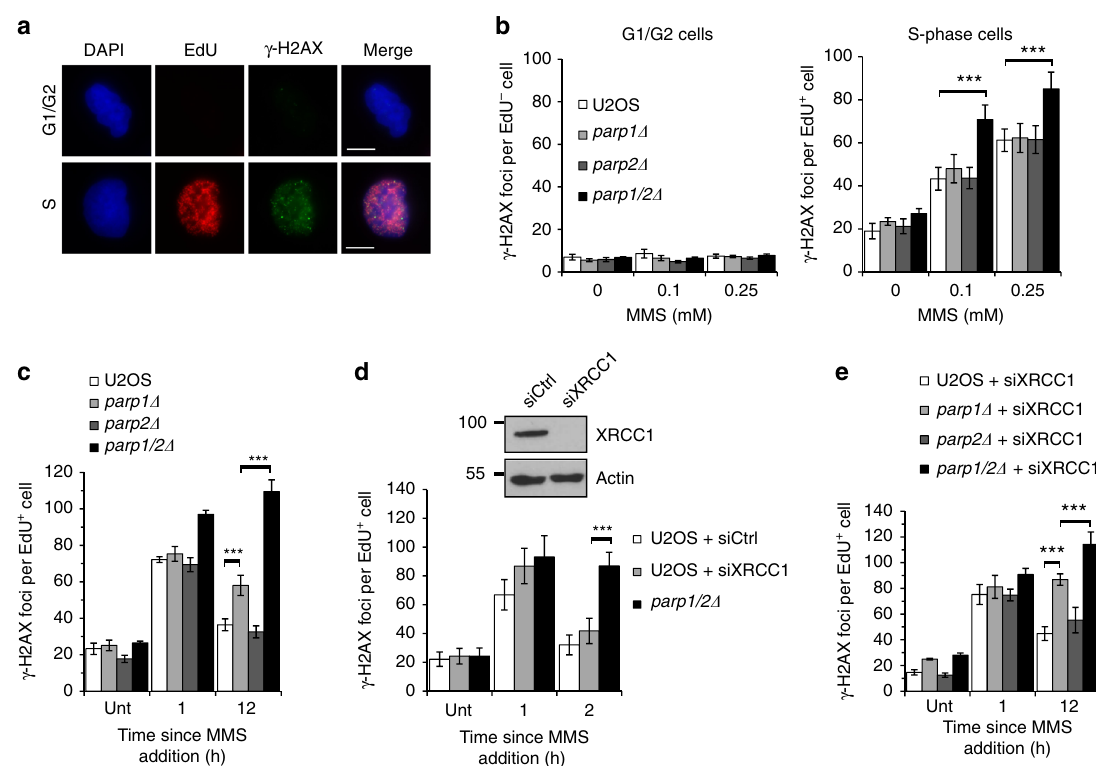
Fig. 3 PARP1 and PARP2 function in the resolution of replication-associated damage independently of BER. a U2OS cells were treated with 1 μ M EdU and 0.25 mM MMS for 1 h, before pre-extraction and fi xation. EdU and γ -H2AX were detected by immuno fl uorescence. Representative images of EdU-positive and EdU-negative nuclei are shown. Scale bars represent 10 μ m. b The indicated cell lines were treated as in a and following immuno fl uorescence γ -H2AX foci quanti fi ed in G1/G2 phase (EdU-negative) and S-phase (EdU-positive) cells. Error bars represent the SEM from four independent experiments. Statistical signi fi cance was determined using a two-tailed Student ’ s t- test (*** p < 0.001). c The indicated cell lines were treated with 1 μ M EdU (Unt), or with 1 μ M EdU and 0.25 mM MMS for 1 h before recovery in fresh media, and γ -H2AX foci quanti fi ed by immuno fl uorescence in EdU-positive cells. Times indicated show hours since addition of EdU and MMS. Error bars represent the SEM from four independent experiments. Statistical signi fi cance was determined as in b . d U2OS cells transfected with control or XRCC1 siRNA, or parp1/2 Δ cells were treated as in c and γ -H2AX foci quanti fi ed in EdU- positive cells (lower panel). Knockdown of XRCC1 in U2OS cells was con fi rmed by Western blotting using the indicated antibodies (upper panel). Times indicated show hours since addition of EdU and MMS. Error bars represent the SEM from four independent experiments. Statistical signi fi cance was determined as in b . e The indicated cell lines transfected with XRCC1 siRNA were treated as in c and γ -H2AX foci quanti fi ed in EdU-positive cells. Times indicated show hours since addition of EdU and MMS. Error bars represent the SEM from three independent experiments. Statistical signi fi cance was determined as in